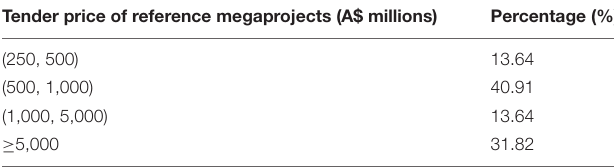
TABLE 6 | Profile of reference megaprojects by